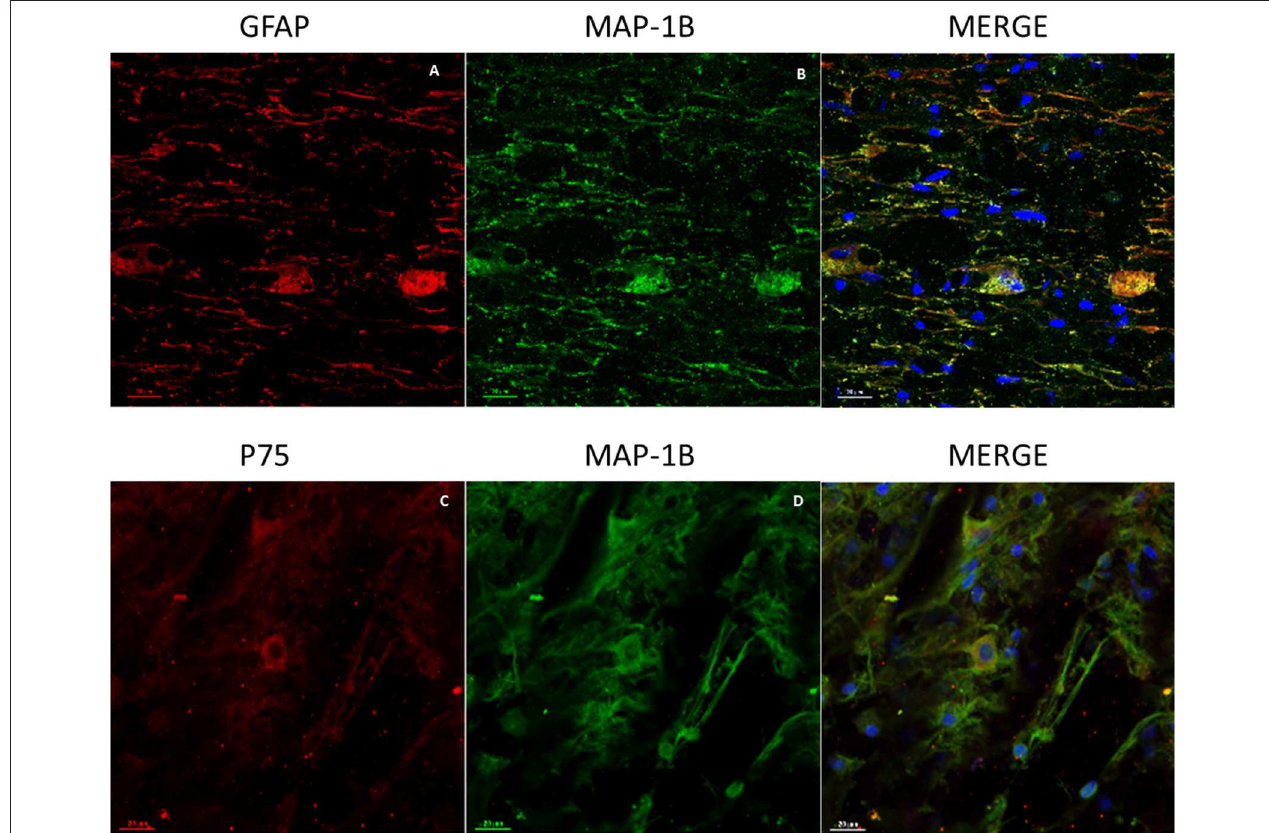
FIGURE 1 | Representative images of GFAP, MAP-1B, and P75 expression in BMSCs at the spinal cord. (A) Immunoreactive cells for GFAP (red). (B) Immunoreactive cells for MAP-1B (green). (C) Immunoreactive cells for P75 with star-like morphology (red). (D) Immunoreactive cells for MAP-1B with long extensions (green). Nuclei contrasted with Hoechst (blue). Scale bars (A–D) = 50 µ m.